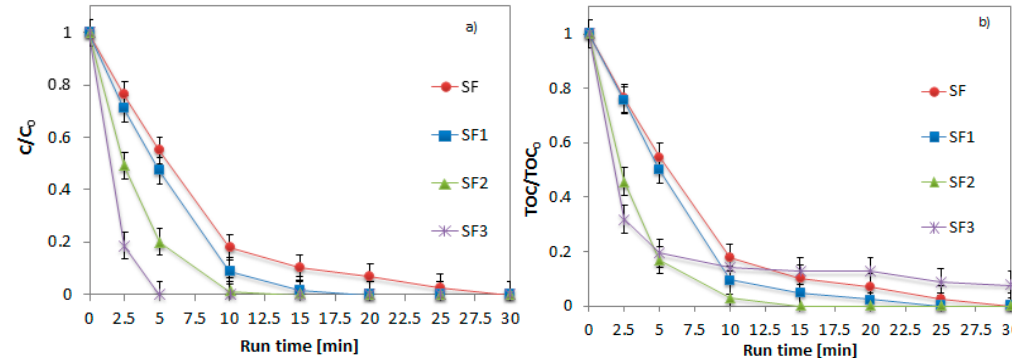
Figure 4. Influence of the Fe 2 O 3 amount on glass spheres in AO7 cold plasma degradation. Discoloration ( a ) and mineralization ( b ) behavior during the run time. AO7 initial concentration: 20 mg / L. Glass spheres amount: 36 g. Applied voltage: 12 kV. O 2 flow rate: 0.18 NL/min.